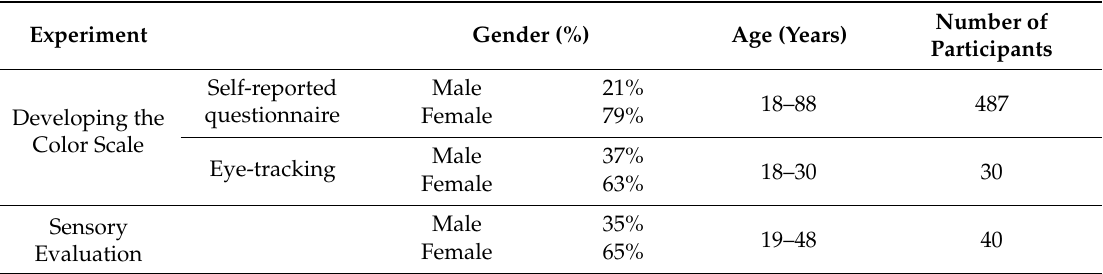
Table 1. Number, gender percentage, and age of the participants in the